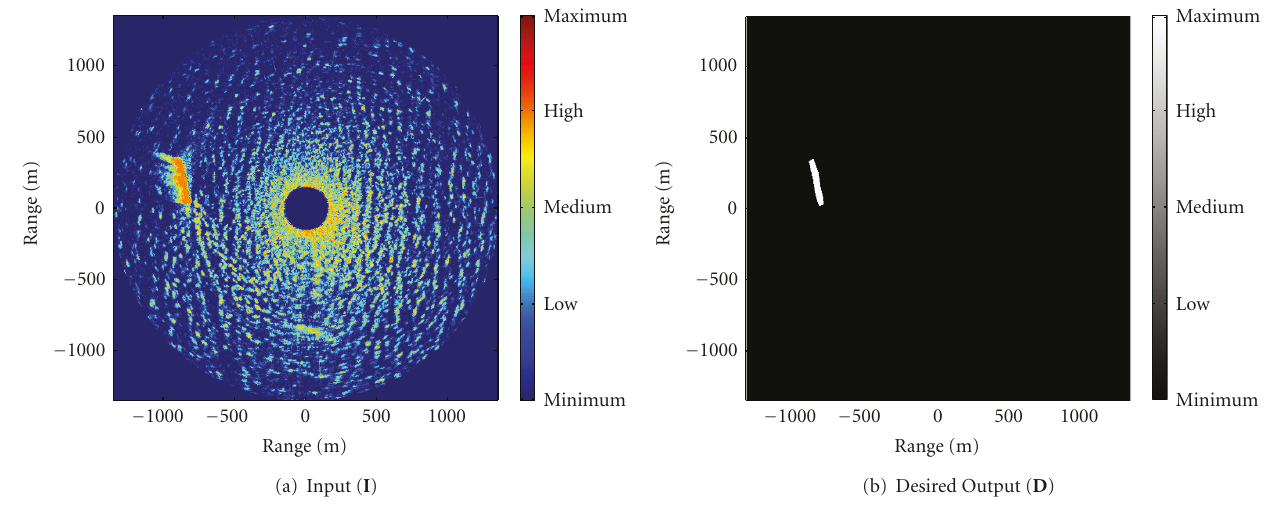
Figure 3: Input Radar Image Containing Target (Ship) in Sea Clutter and its Desired System Output.